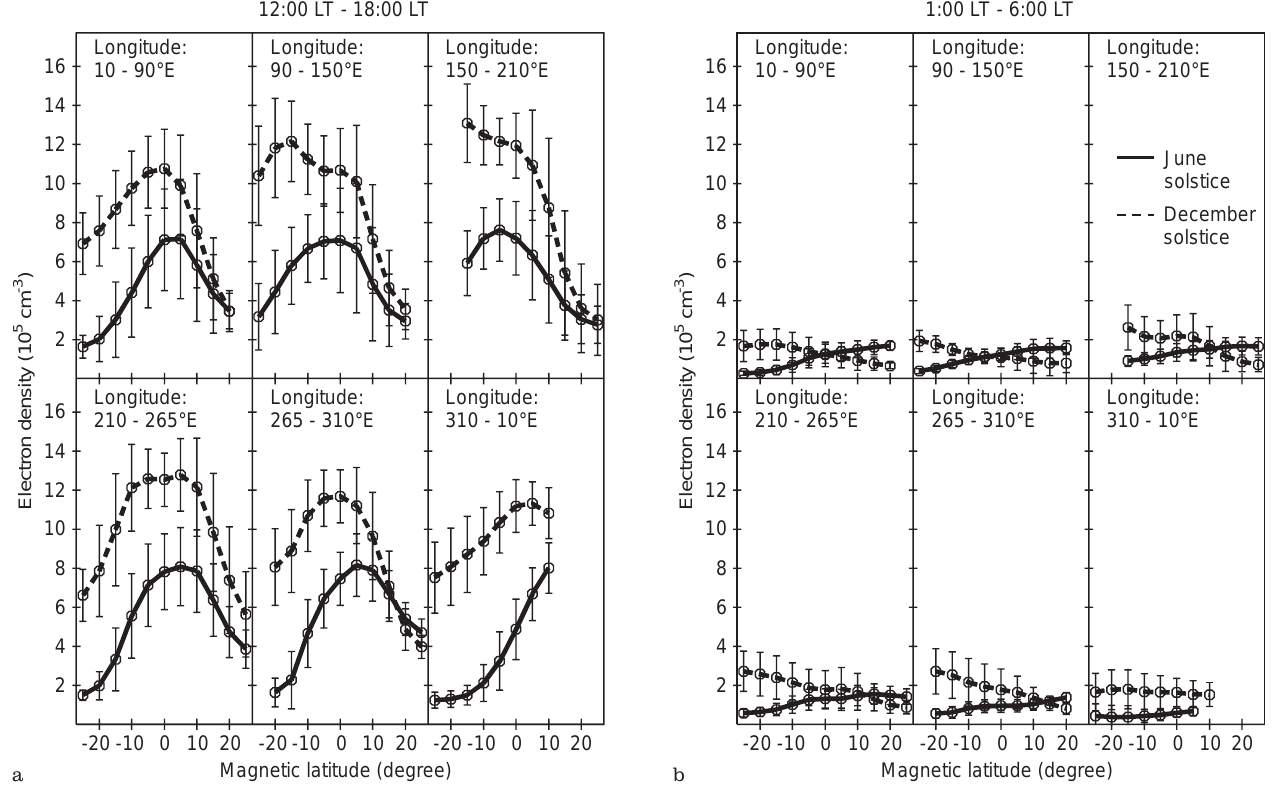
Fig. 3. Latitudinal variations of the average a daytime (12:00–18:00 LT), b night-time (01:00–06:00 LT) observed electron density in six longitude sectors. The longitudinal range of each sector is shown at the top of